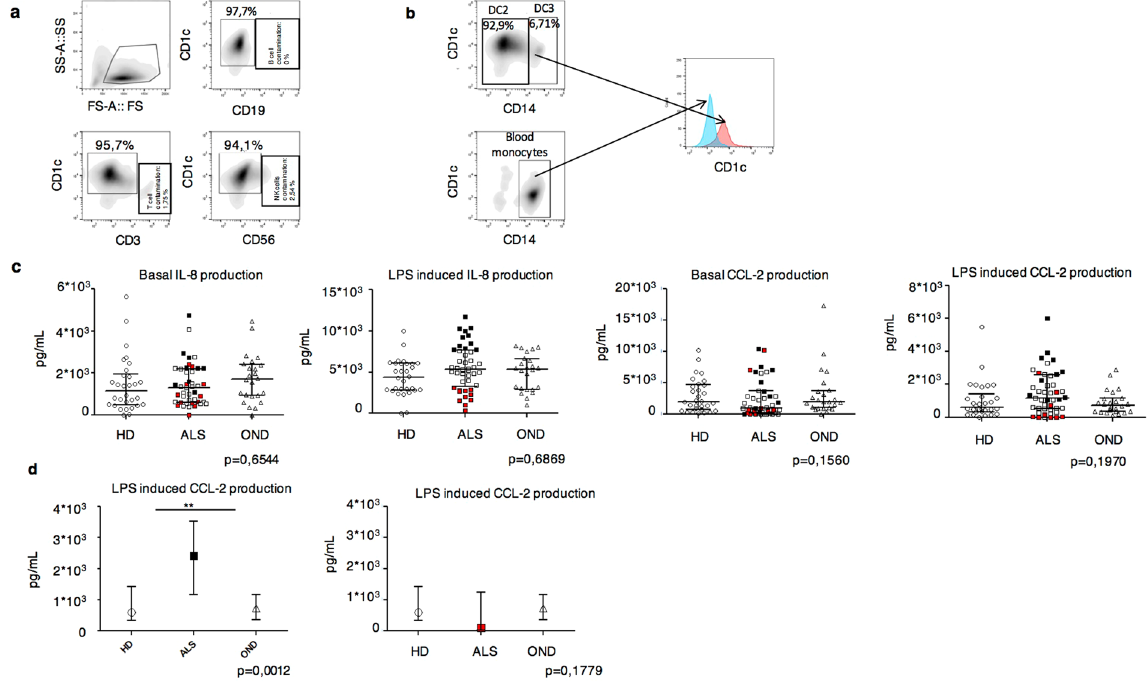
Figure 2. Amounts of spontaneous or LPS-induced chemokine production by DCs purified from peripheral blood of ALS patients (n = 52), HD (n = 36) or OND (n = 25). ( a ) Cytofluorimetric analysis of sorted DCs. The percentages of CD1c high cells and of the T, B and NK cell contaminants are shown. ( b ) CD1c expression levels shown by CD14 + DCs and CD14 + monocytes. Notice that the two cell types can be distinguished based on the levels of CD1c expression. ( c ) Scatter plots of the amounts of IL-8 and CCL-2 produced by DCs from ALS, HD and ODN 24 h after in vitro culture in the presence or absence of LPS. Black dots in LPS-induced IL-8 plots (second to the left panel) are the selected patients with high efficiency of IL-8 production, red dots represent patients with low IL-8 production. ( d ) Efficiency of LPS-induced CCL-2 production by DCs from the selected high IL-8 producers. Each dot represents a patient. ** P <